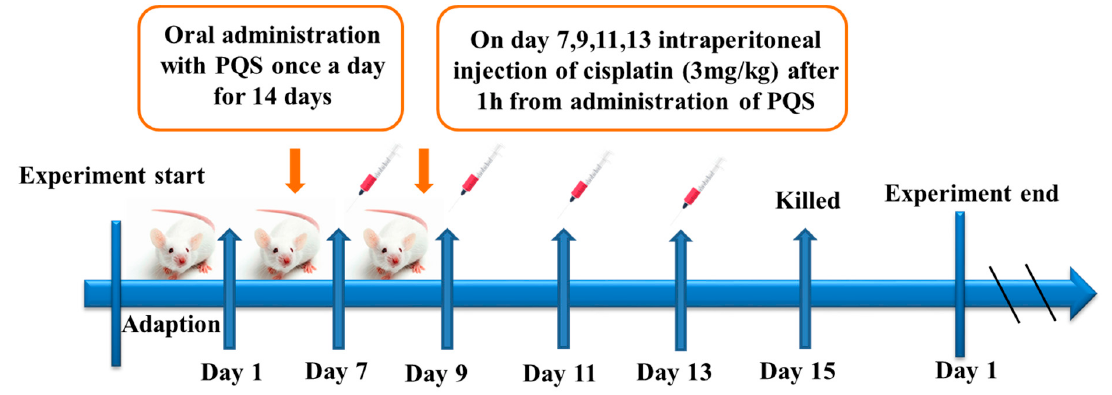
Figure 10. Experimental Flow Chart.